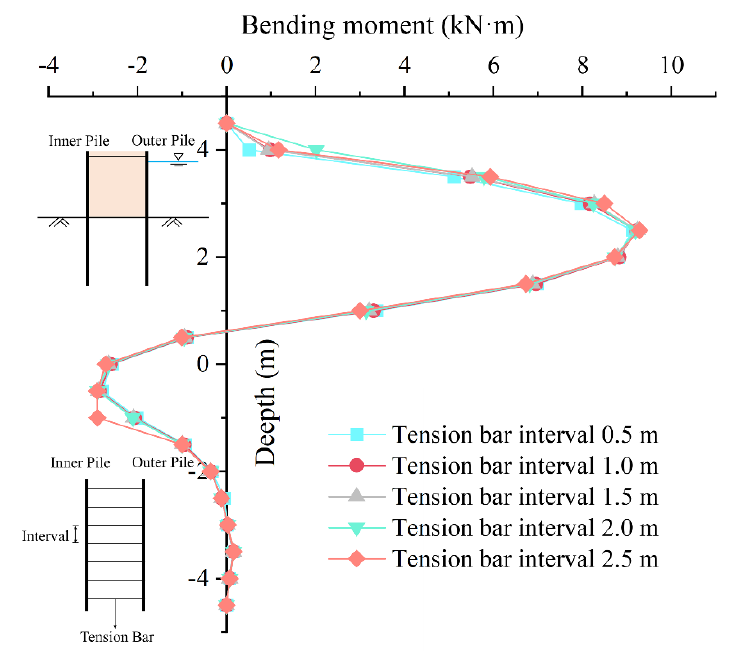
Figure 19. Pile bending moment of different tension bar interval conditions.